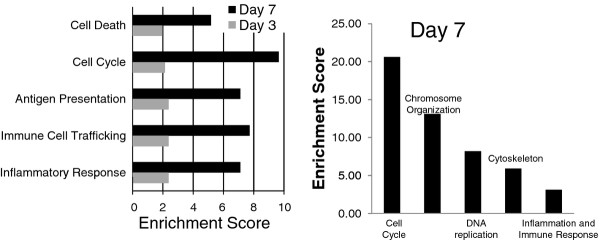
The enriched biological functions of up-regulated genes, as determined by (left) IPA and (right) DAVID. The IPA enrichment score is reported as the -log10 of the FDR-adjusted P-value. DAVID clusters redundant or highly related annotations into clusters and reports the enrichment as the –log10 of the average P-value of the terms in each annotation cluster. DAVID did not identify any significant annotations for genes which were up-regulated on day 3, and only enrichments for day 7 are shown.